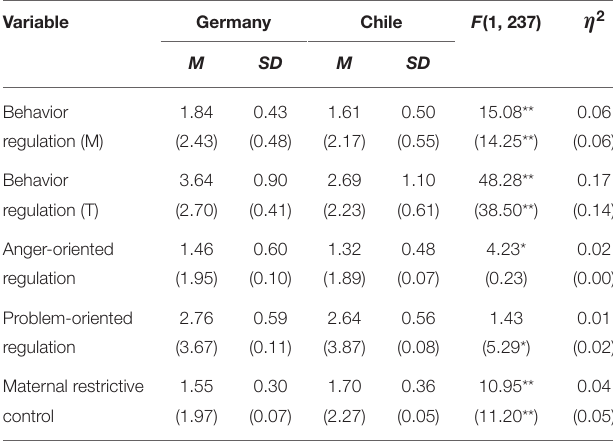
TABLE 1 | Means, standard deviations, and cultural mean